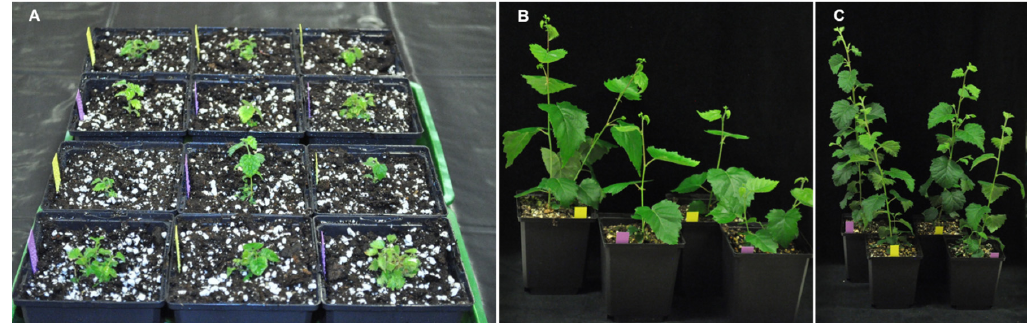
Figure 3. ( A ) Plants of B . pendula and B . pubescens at the start of the acclimatization period. ( B , C ) B . pendula and B . pubescens after 51 days of acclimatization, respectively. The purple and yellow tags indicate plants propagated on solid medium and in the TIB, respectively.